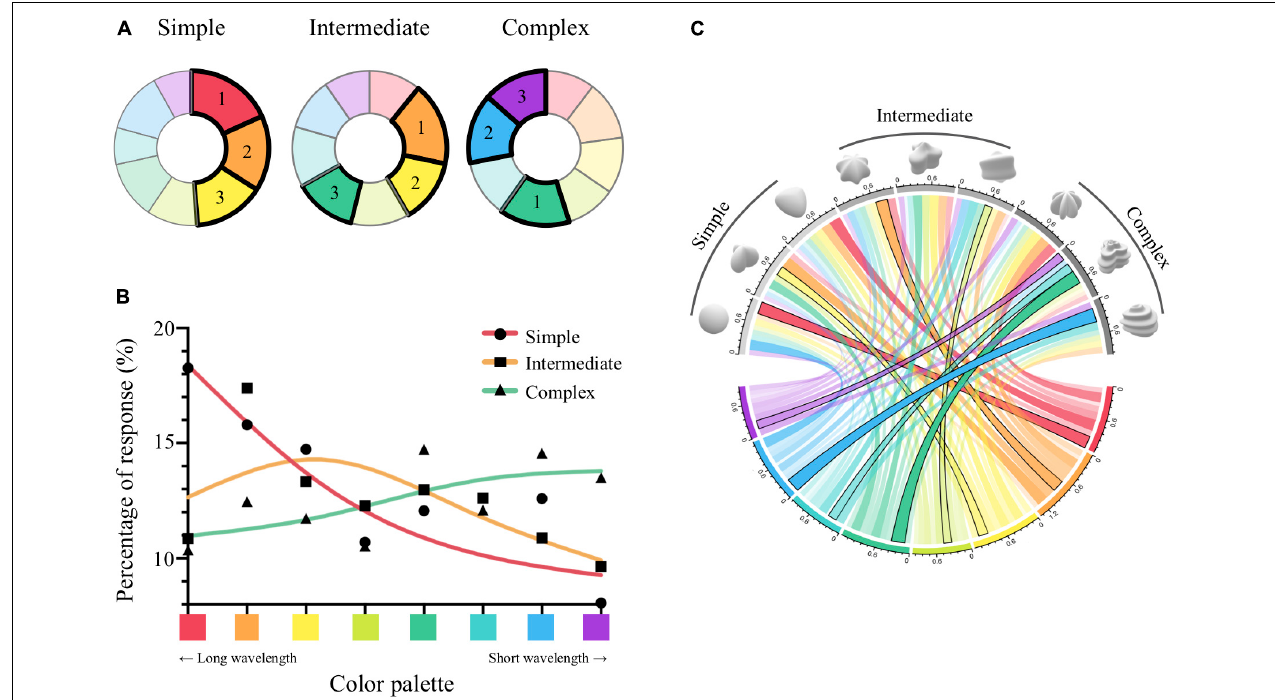
FIGURE 3 | Results from Experiment 1. (A) Pie charts illustrate the percentage of responses for each hue according to complexity condition, indicated by the area on the chart for each color. Hues ranked as the first, second, and third are marked with bold lines and numbers. (B) Distributions of the percentage of responses for hues were fitted depending on the complexity level using spline interpolation. The x -axis indicates the eight color palettes. Y -axis is the percentage of the hue choice for complexity condition (simple, intermediate, complex). (C) The chord diagram illustrates the degree of association between each shape and color palette. Shapes are presented in order of complexity condition on the upper half circle. Colors on the lower half circle indicate the eight hues. Color transparency of the connected line shows the percentage of responses. Black outlines of the links indicate the connection of a shape with the highest % response in each hue.